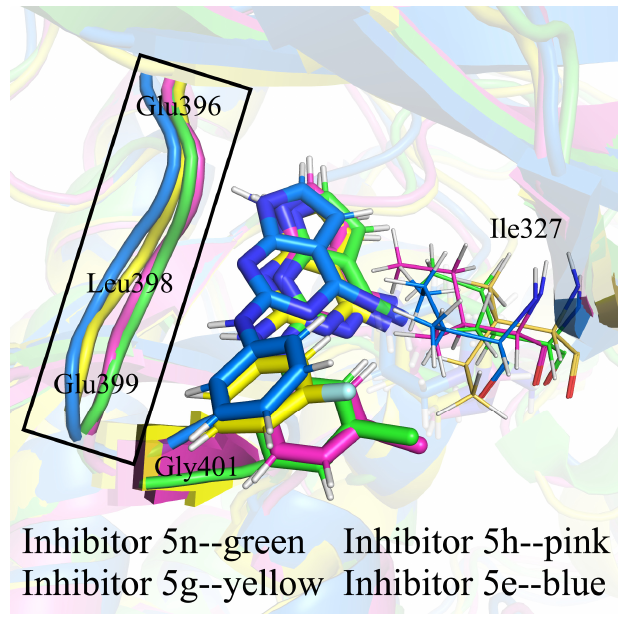
Figure 13. The conformational comparison of Ile327, the 2-benzene ring, and the hinge region of the inhibitors in the four